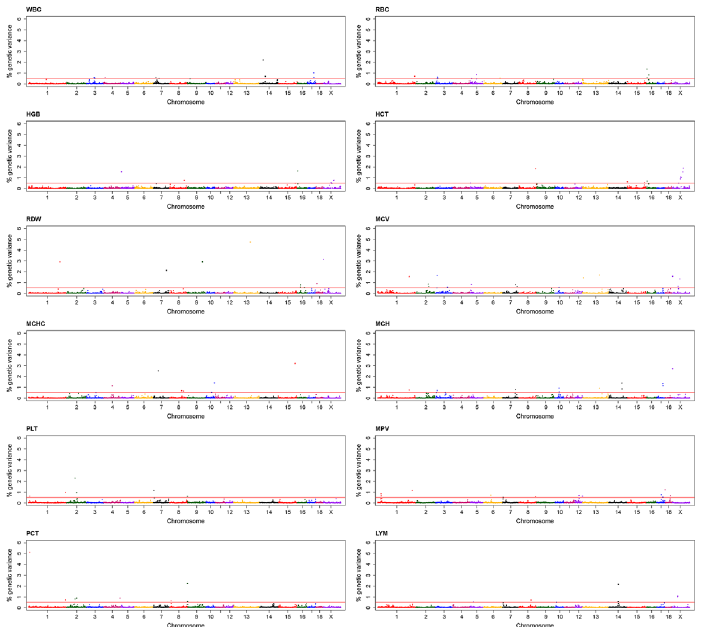
Fig 2. Manhattan plots displaying the genome-wide association based on the Bayesian multi-marker approach (Bayes B) for haematological traits in German Landrace. Horizontal line represents the threshold of 0.05% of additive genetic variance explained by 1-Mb marker